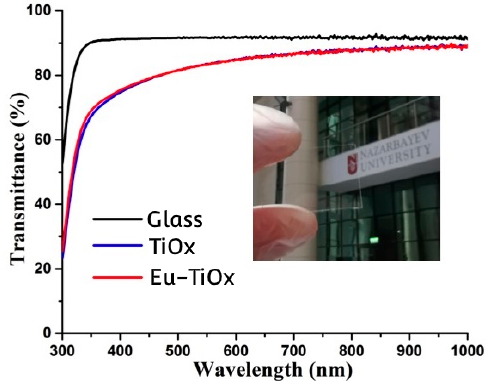
Figure 8. UV-Vis spectrum of a bare glass slide, undoped and Eu-doped TiOx films. Inset is a digital image of Eu-doped TiOx film deposited on a glass slide.